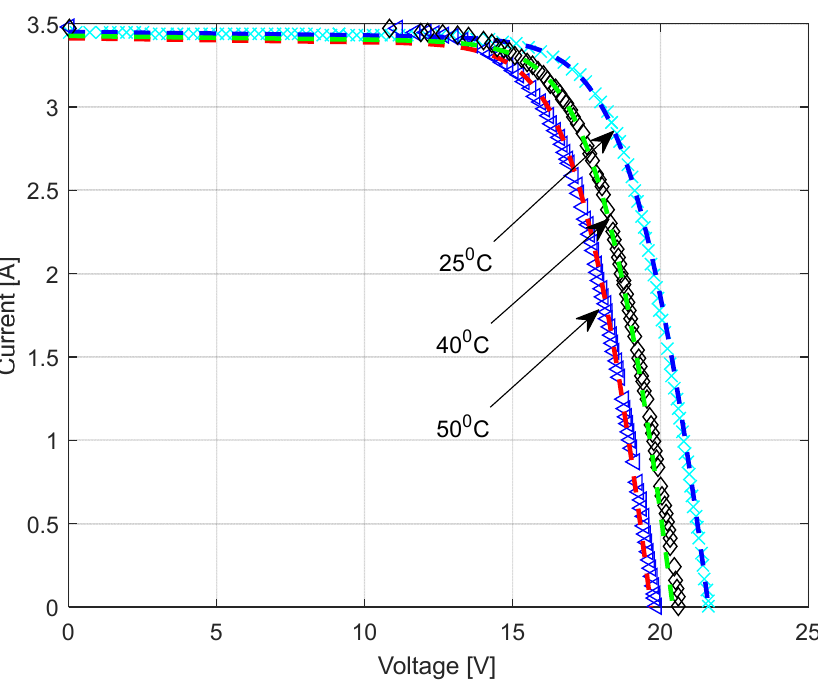
Figure 18. Current-voltage characteristics at 1000 W/m 2 for different temperature levels.